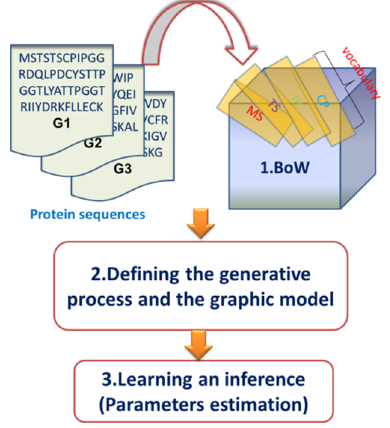
Figure 2. An overview of the topic modeling process.